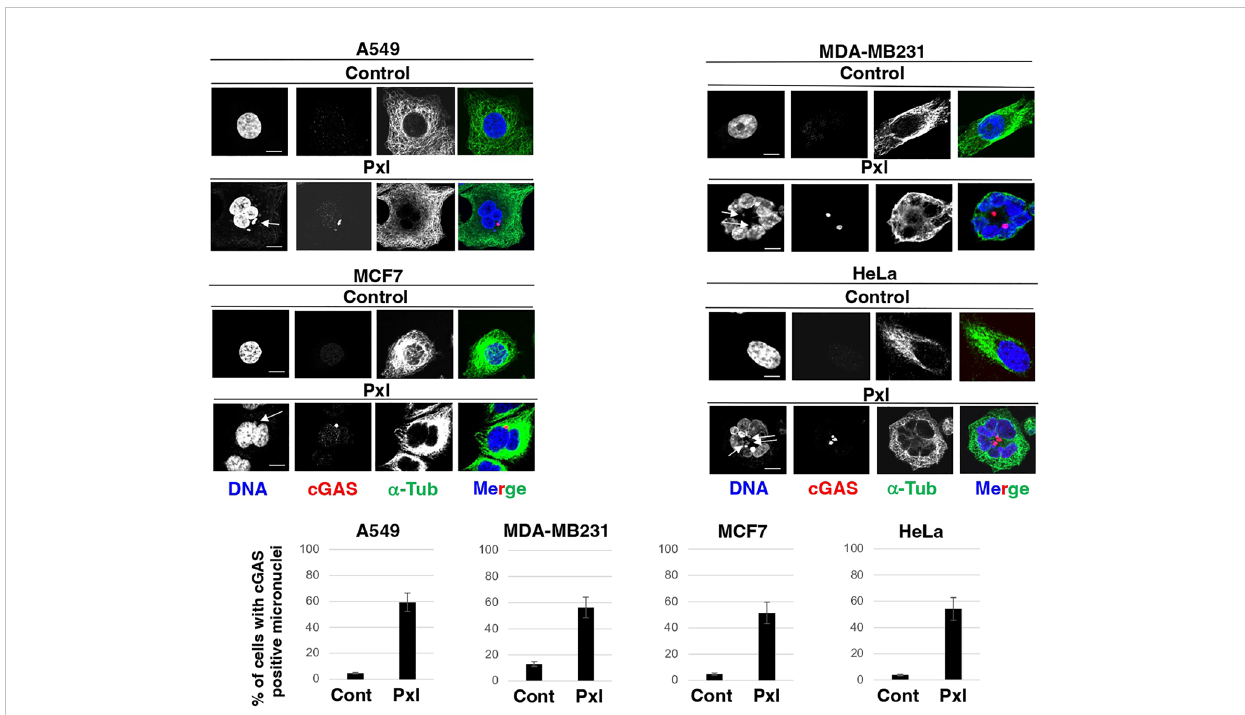
FIGURE 1 Pxl increases cGAS-positive micronuclei formation. A549, MDA-MB231, MCF7 and HeLa cells were treated for 48 hours with either vehicle (DMSO) as control or Pxl (4 nM), fi xed and processed for indirect immuno fl uorescence (IF) staining for the indicated antigens. Representative IF images are shown. Scale bar: 5 m m. Lower graphs show a quantitation of cGAS-positive micronuclei (error bars refer to variability within three independent experiments; around 200 cells were scored for control and Pxl treatment per